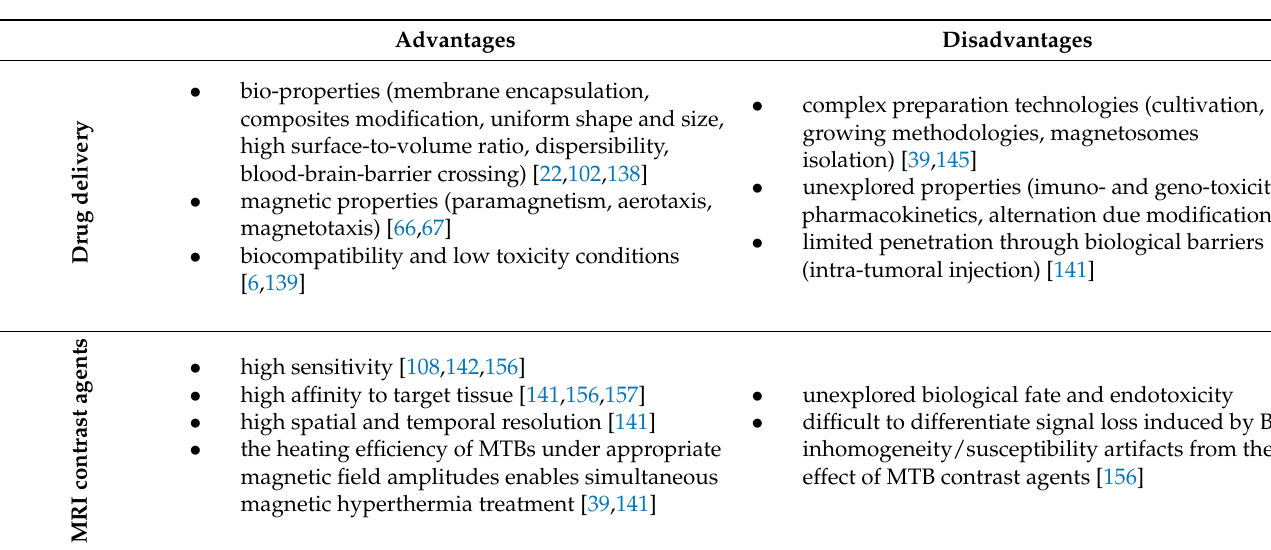
Table 2. Comparison of advantages and disadvantages of magnetosome production for biomedical